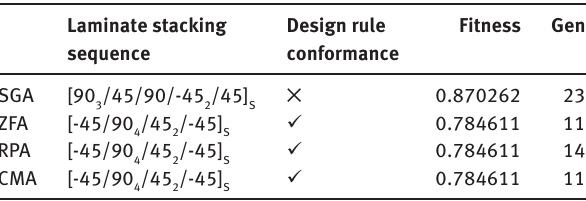
Figure 8 Analyses of maximum fitness of particular generation and global best fitness over number generation for rule 6. Table 6 Optimal results for rule